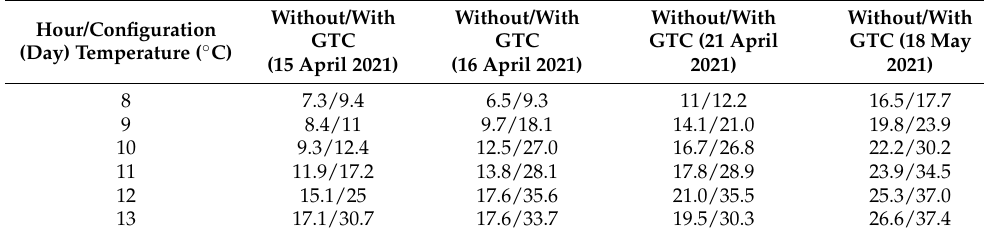
Table 9. Ventilation (supply) air temperature without/with GTC.